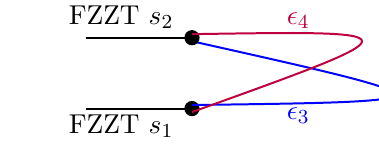
Figure 13 . (a): numerical results for the matrix model scattering of the tree level long ! long + closed amplitude (4.33) as a function of the outgoing long string renormalized energy (cid:15) 1 and outgoing closed string energy ! 3 . (b) and (c): ratio of numerical results computed from the worldsheet to those computed from the matrix model for tree-level long ! long + closed string amplitude.